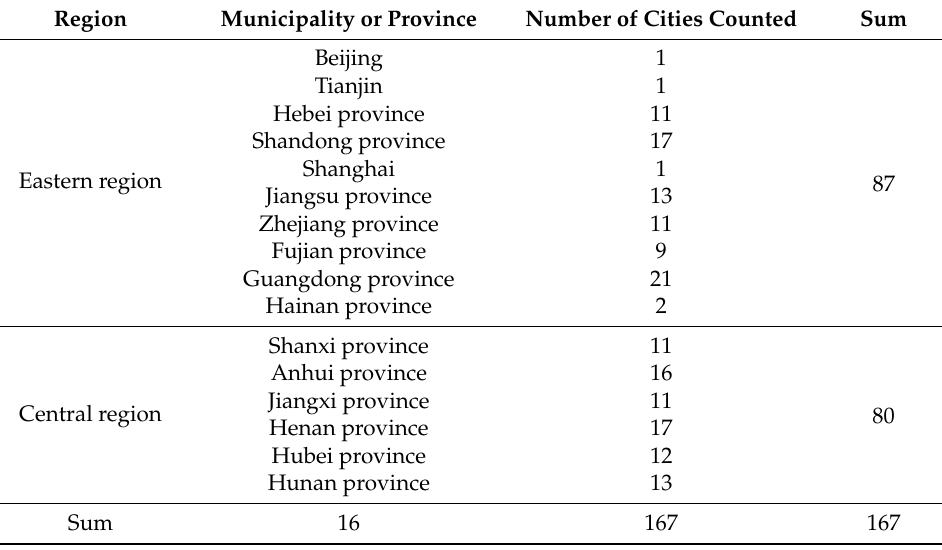
Figure 1. The four major Chinese economic regions in this study. Table 1. Specific administrative units studied.